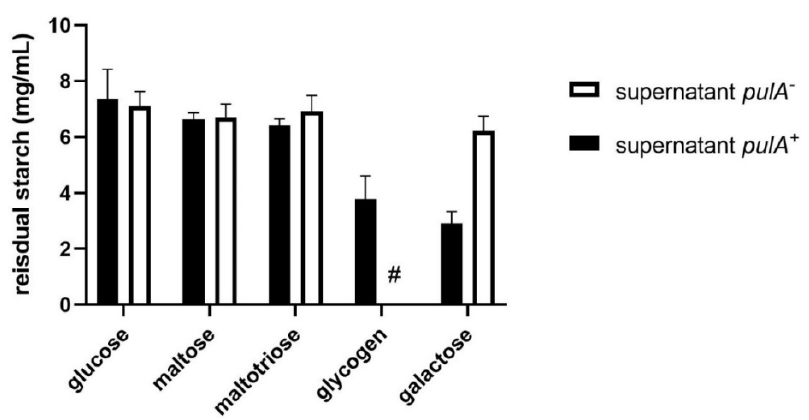
Figure A2. Starch degrading activity in spent medium of L. crispatus amylopullulanase sufficient and deficient strains grown on NYC-, glucose, maltose, maltotriose, glycogen (only pulA + ) and galactose. Cells were cultured in NYCIII medium supplemented with these carbohydrates and after centrifugation and resuspension of the pellet incubated in a starch solution (7.5 g/L). Experiments were carried out with a minimum of (two) biological replicates; averages and standard deviations are shown. Hashtag (#) indicates no data due to the absence of growth of this strain on glycogen.